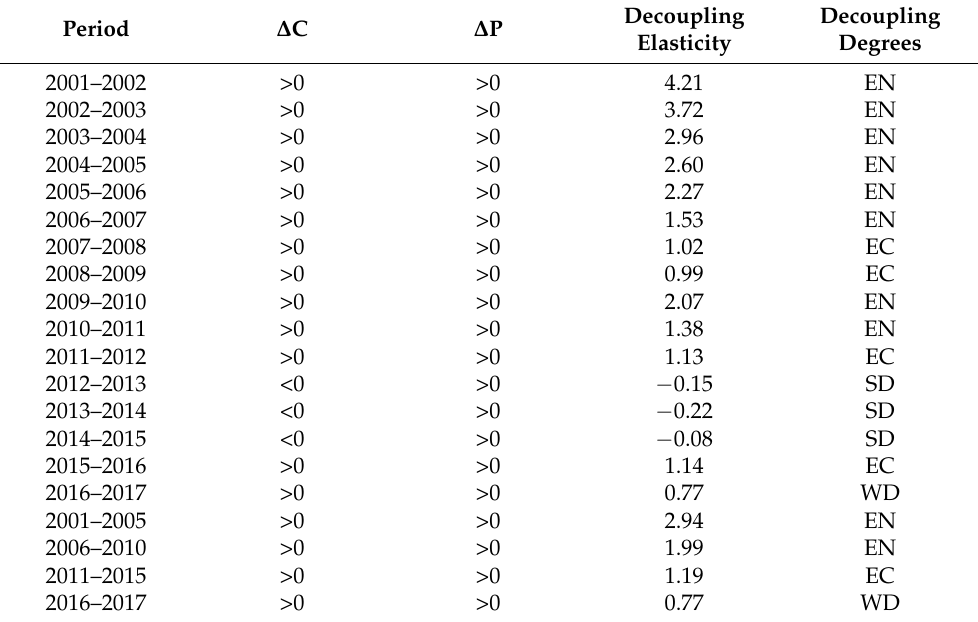
Decoupling Elasticity